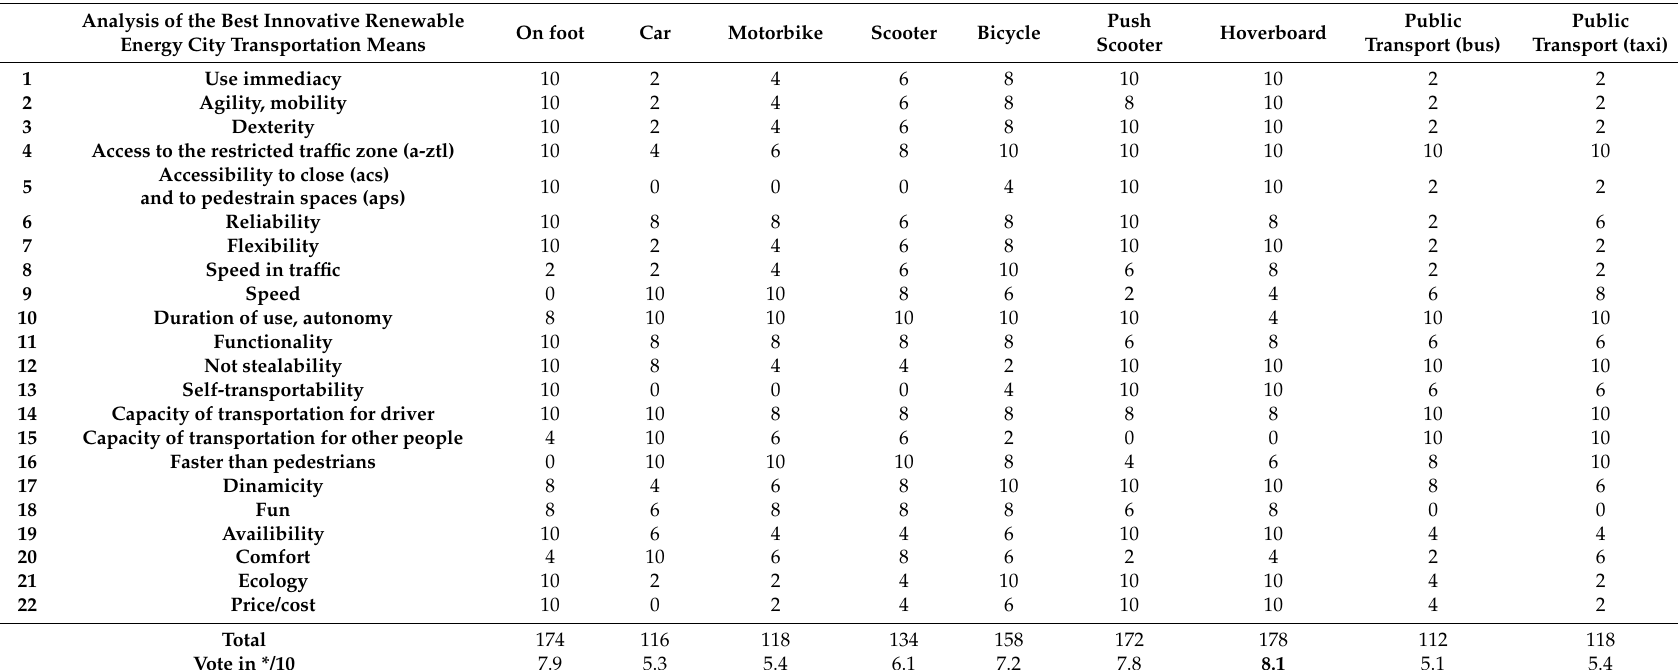
Table 1. Analysis of the best innovative renewable